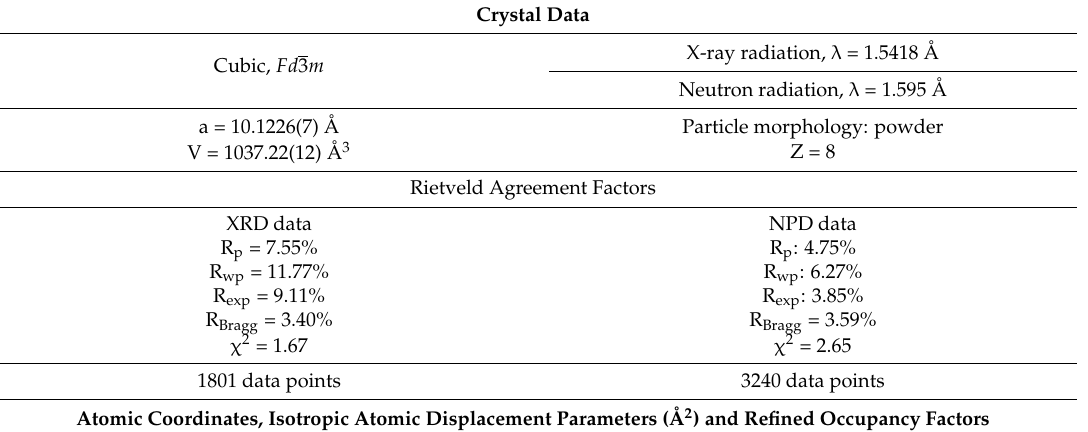
Figure 1. Rietveld-refined XRD pattern of KSbTeO 6 at 298 K, characteristic of a cubic pyrochlore phase. The experimental XRD data is represented with red crosses, the calculated profile is shown with a black solid line, and their difference is shown at the bottom (blue line). Vertical green symbols indicate allowed peak positions. Table 1. Unit–cell, fractional atomic coordinates, atomic displacement parameters, refined occupancy factors and Rietveld agreement factors of KSbTeO 6 in the cubic space group Fd 3 m (No. 227), with Z =